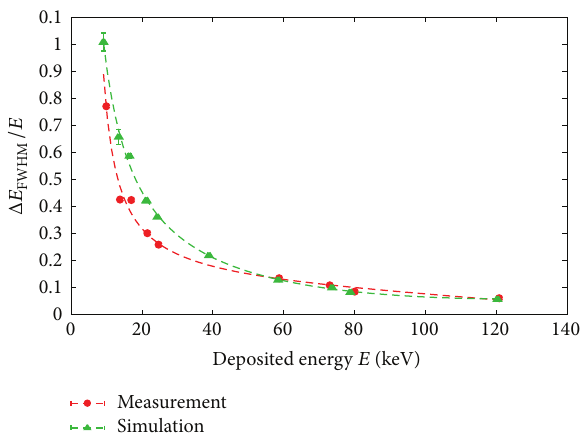
Figure 2: Simulated and measured relative energy resolution /𝐸 of the Timepix detector with a 1mm thick CdTe sensor Δ𝐸 FWHM and 110 𝜇 m pixel pitch in time-over-threshold mode as a function of is the full width at half maximum of deposited energy 𝐸 . Δ𝐸 FWHM the full-energy peak at energy 𝐸